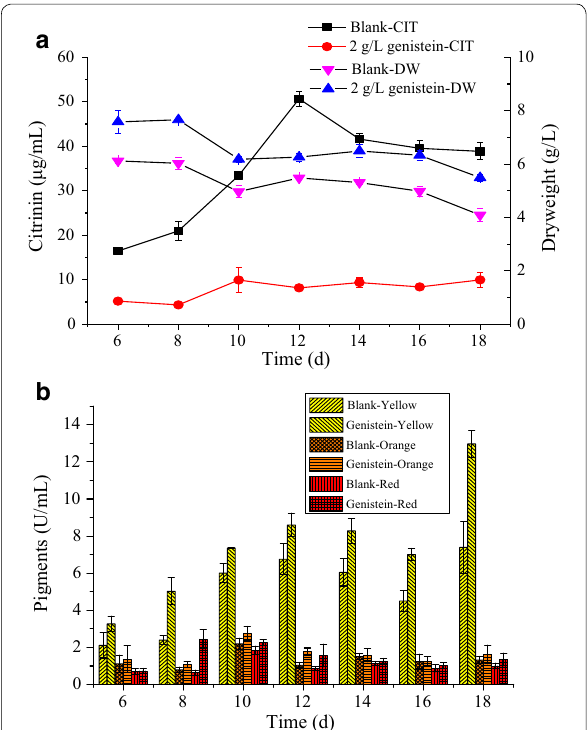
Fig. 2 Effects of genistein (2.0 g/L) on a citrinin (CIT), biomass, and b pigments production by MAL in different content of rice powder in liquid-state fermentation medium at 30 °C, 180 rpm for 12 days. Significant differences of different the dots and the columns at p < 0.05